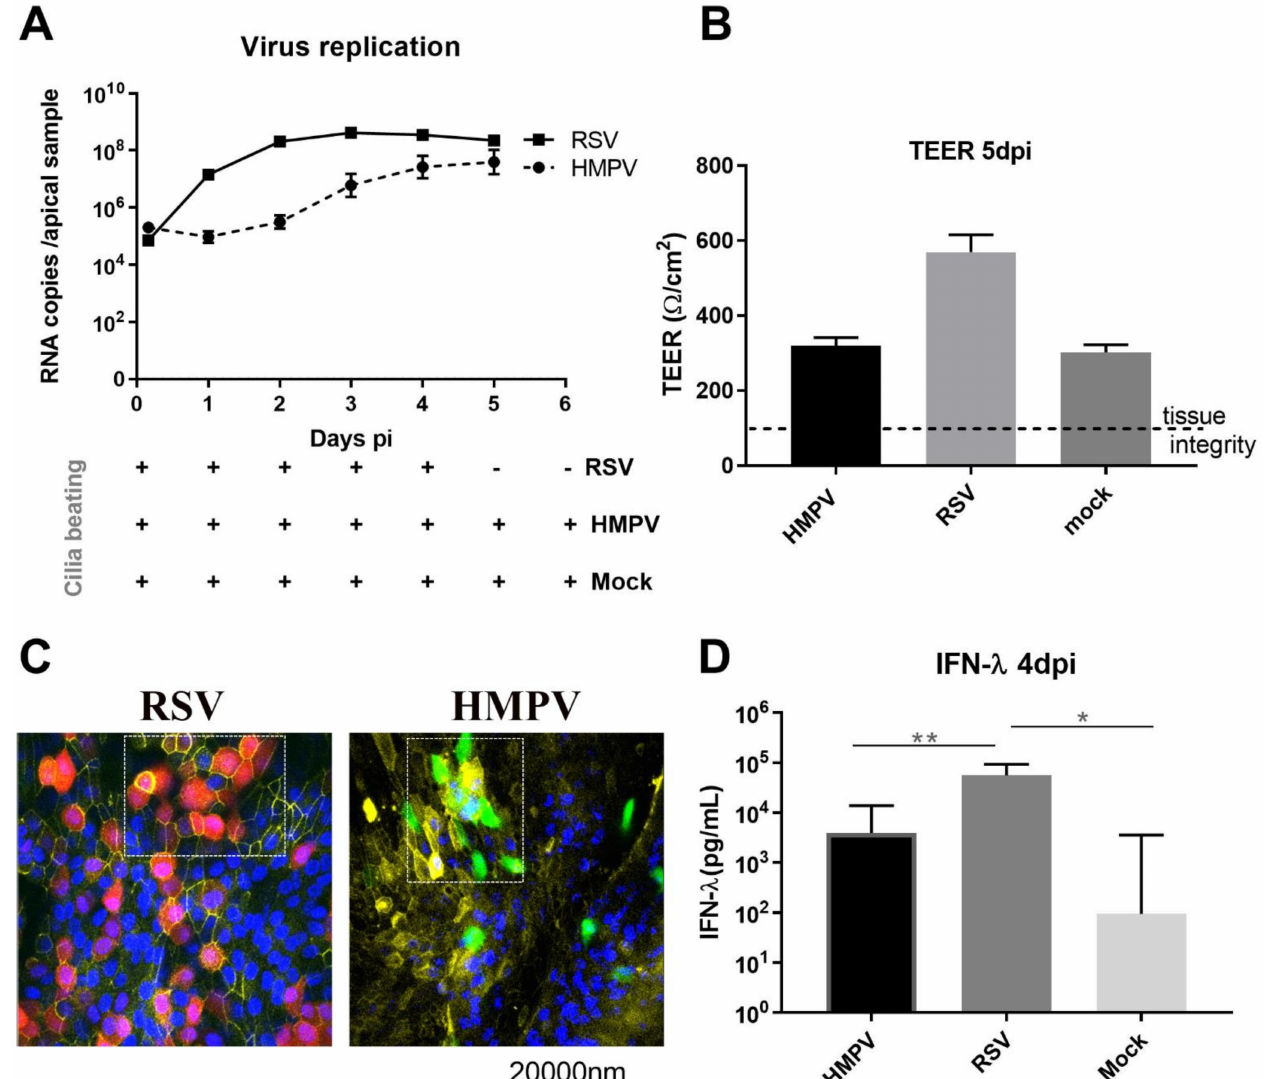
Figure 1. Differential pathogenesis of HMPV and RSV in in vitro reconstituted airway epithelia. Epithelial tissues were inoculated apically with RSV and HMPV (MOI = 0.02) and washed three times after 4H. ( A ) Viral RNA loads were then measured by RT-qPCR from daily collected apical washings. Cilia beating was determined (cf. movies in Supplemental Data). +: cilia are still beating; − : cilia movement is blocked by the infection. ( B ) In the same infected tissues, TEER was measured at day 5 pi. ( C ) Images acquired by confocal microscopy from the apical surface of the RSVmcherry (red cells, left panel) and HMPV/GFP (green cells, right panel) infected tissues after fixation and staining of tight junction marker, ZO-I, (yellow, a pseudo-color used instead of the original one -magenta- for a better interpretation of the image) and nuclei (blue) at 5 dpi (of note, infected cells were only detected at the apical surface as shown in Figure S1). White squares highlight groups of infected cells without syncytia formation. ( D ) IFN- λ induction was also measured from basal samples at 4 dpi by ELISA in mock, RSV, and HMPV-infected tissues. Statistical significance relative to non-infected tissues was calculated using the two-way ANOVA, N = 4. ** p < 0.01; * p <